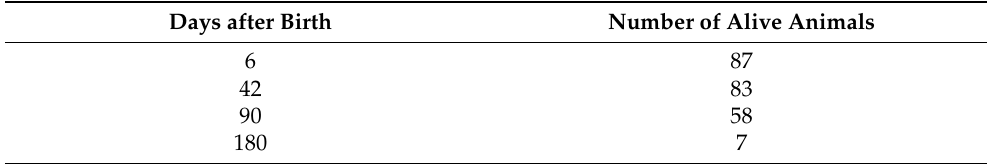
Table 1. Numbers of living animals for each timepoint. Days after Birth Number of Alive